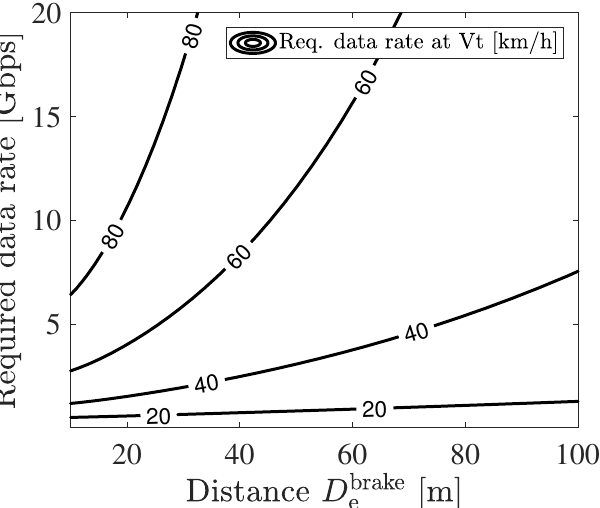
Figure 7. The sensor data rate required for the ego vehicle placed at D e to prevent a collision with the target vehicle driving at V t